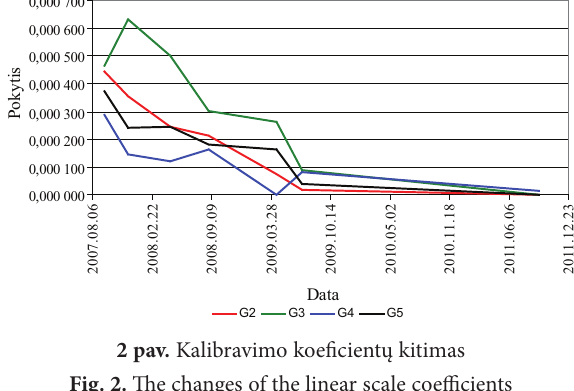
3. Sunkio pagreičio vertikaliojo gradiento tyrimas